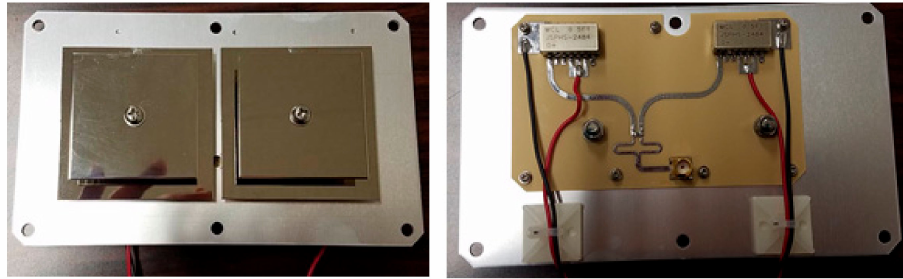
Figure 8. Implemented antenna using two patch antennas. The left figure is the front side of the antenna, and the right figure is the back